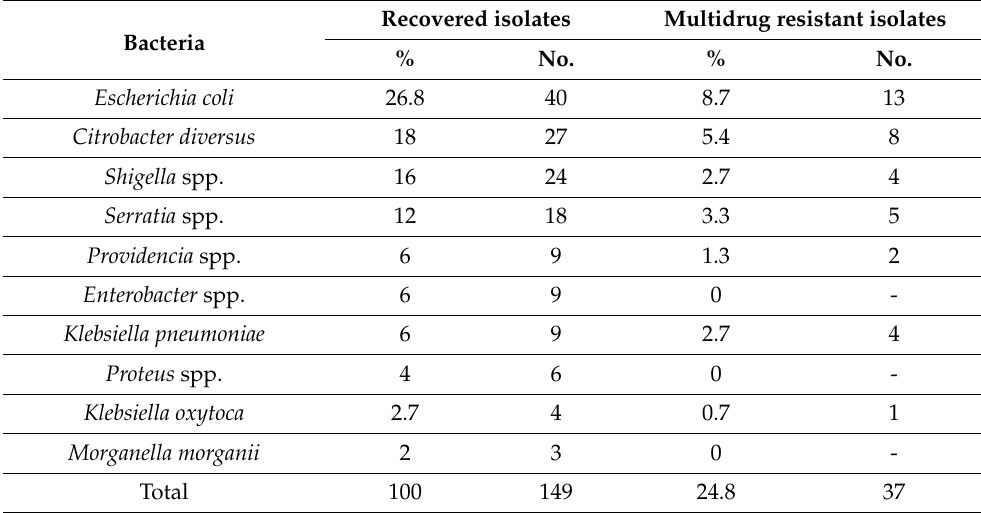
Table 3. Occurrence of multidrug resistant Enterobacteriaceae isolated from diarrhoeic calves.